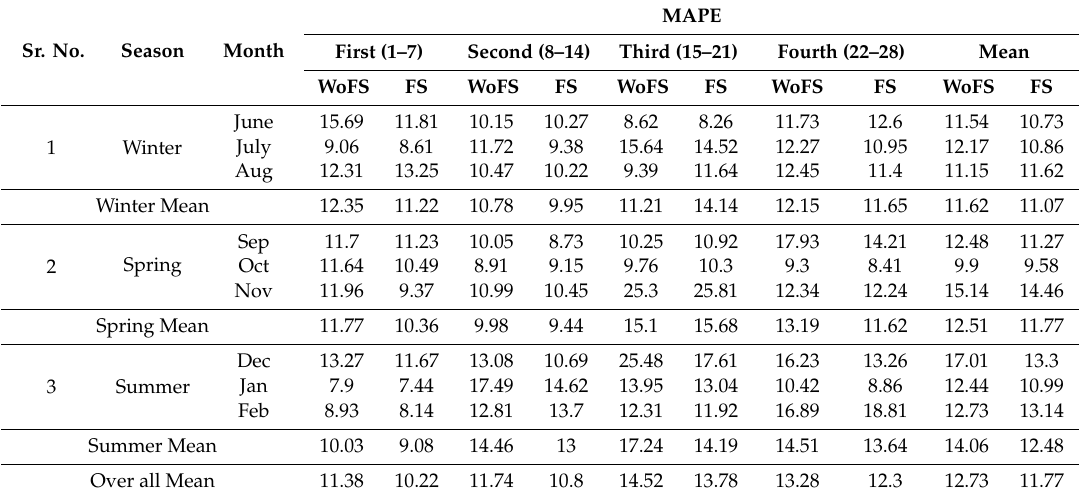
Table 5. Mean absolute percentage error (MAPE) with FS and